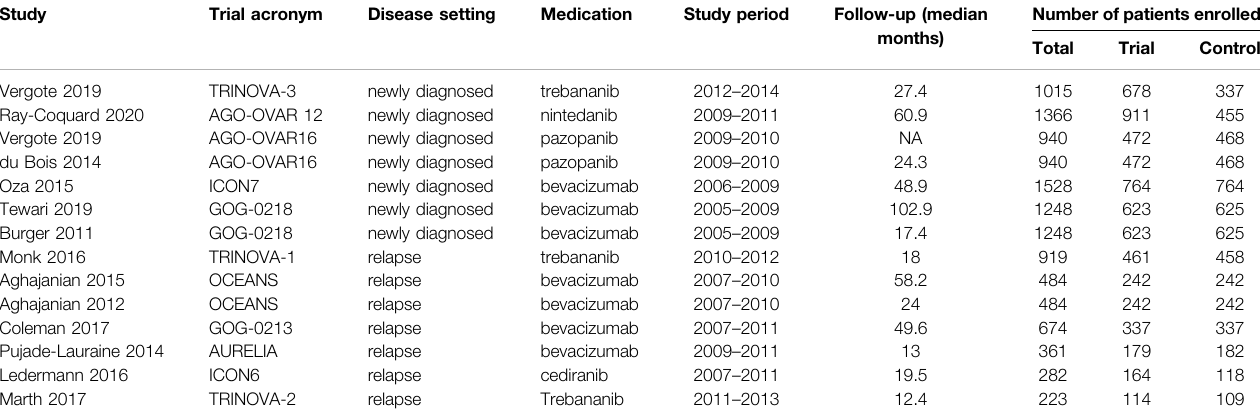
TABLE 1 | Characteristics of the individual studies and enrolled